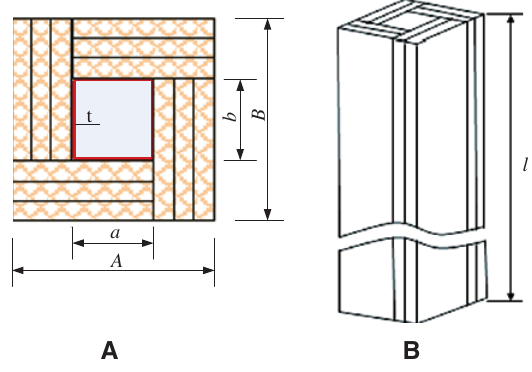
Figure 6: Schematic showing the dimensions of the composite column. (A) Column cross-sectional view and (B) column axonometric